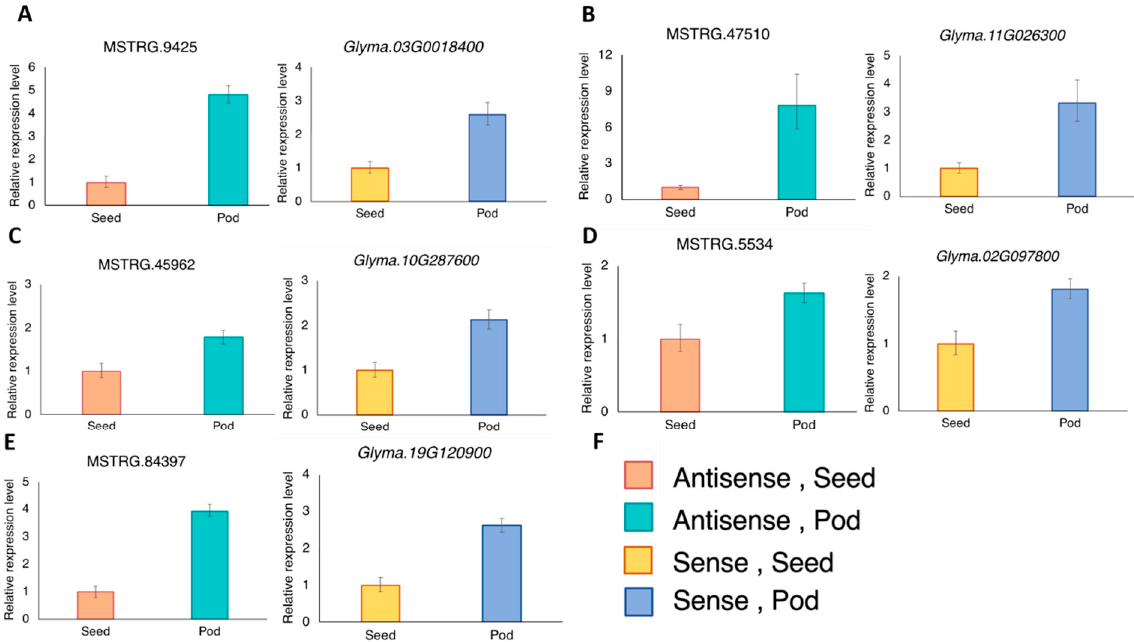
Figure 3. The expression levels of the antisense and their corresponding sense transcripts in the developing seed and pod were analyzed using RT-qPCR. The antisense and sense pairs are ( A ) MSTRG.9425 and Glyma03G0018400 ; ( B ) MSTRG.47510 and Glyma.11G026300 ; ( C ) MSTRG.45962 and Glyma.10G287600 ; ( D ) MSTRG.5534 and Glyma.02G097800 ; ( E ) MSTRG.84397 and Glyma.19G120900 ( GmMATE4 [20]); ( F ) The color key of the bars shown in panel A–E. Three RT-qPCR reactions were done for each template and primer pair combination. One RT-qPCR was regarded as one technical replicate. Each bar represents the mean of three technical replicates ± standard deviation. The expression was normalized to the reference gene, VPS [38] using the 2 −ΔΔ Ct method. Similar expression trends were obtained from another biological replicate using a separate set of seed and pod from three other plants. Results of the biological replicates are shown in Supplementary Figure S1.